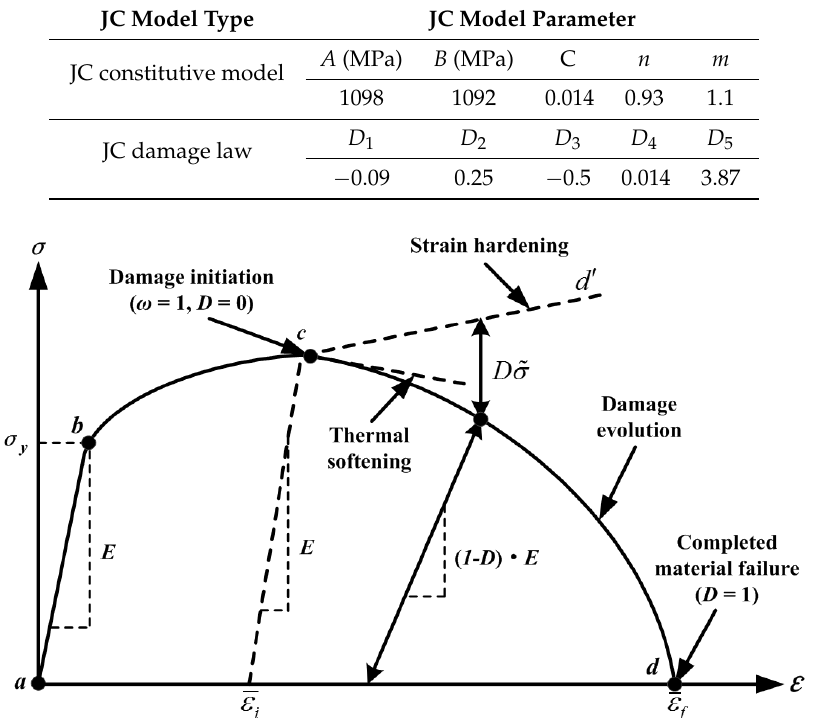
Table 2. Input parameters for Johnson-Cook (JC) constitutive model and JC damage law [21,22].